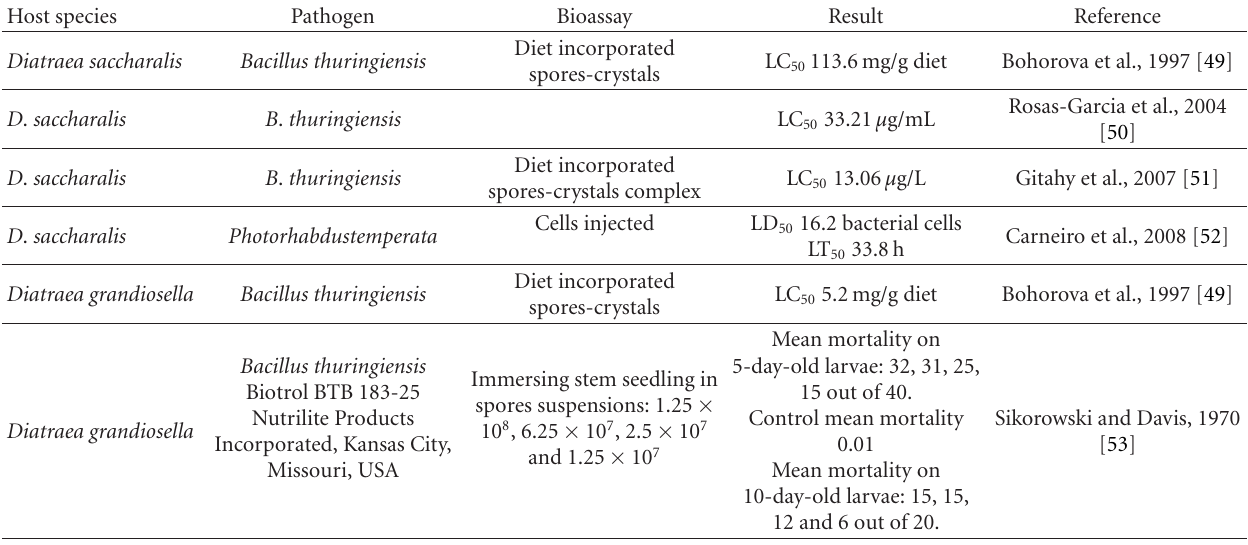
Table 5: Entomopathogenic-bacteria bioassays on Diatraea